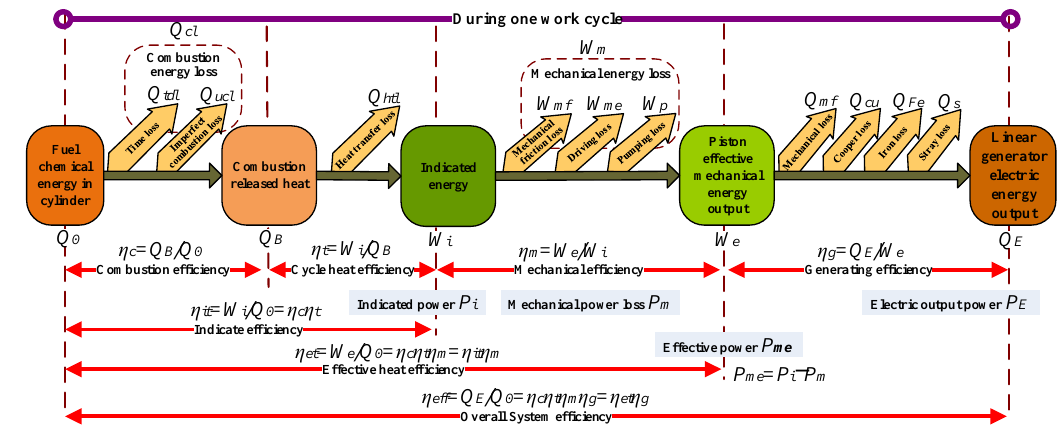
Figure 3. System energy flow diagram.